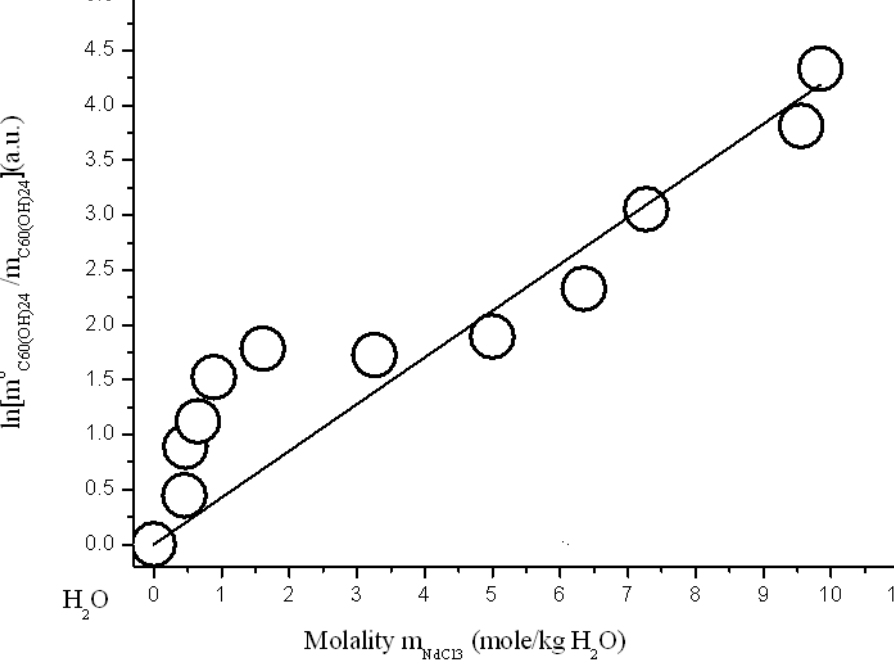
Figure 12. Branch of crystallization С 60 (ОН) 24 *18Н 2 О in the diagram of solubility in ternary system С 60 (ОН) 24 —NdCl 3 —